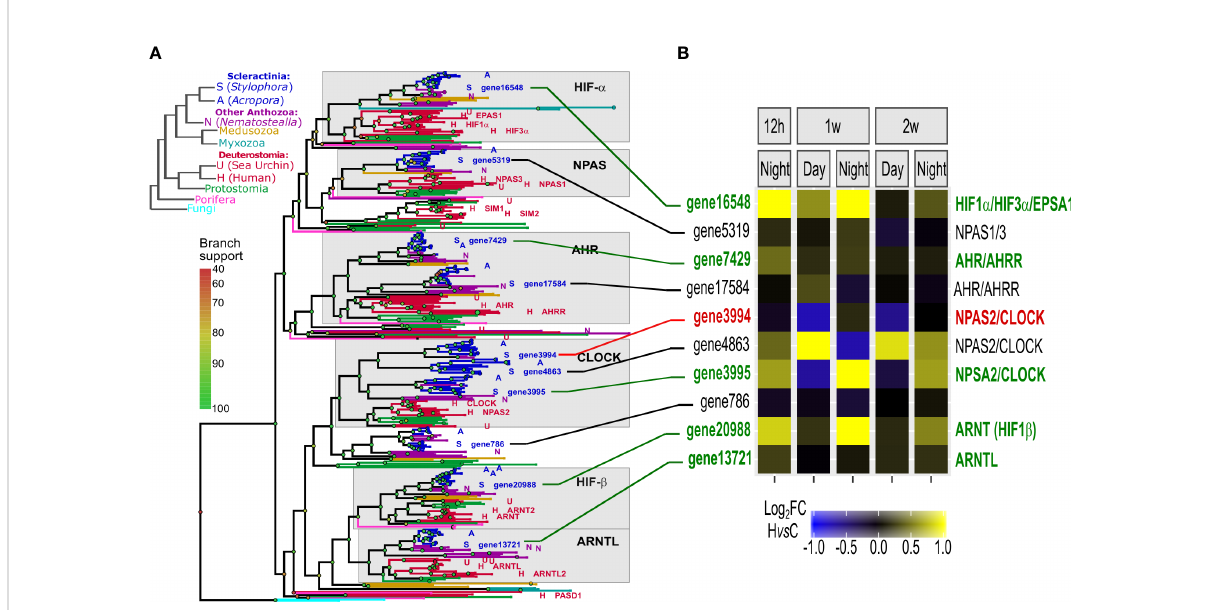
FIGURE 5 Functional and protein-structure conservation of HIFs in metazoa and cnidaria. (A) Left: Metazoan phylogenetic species-tree representing evolution of major species clades. Representative species are symbolled A/S/N/H to denote: Acropora , Stylophora , Nematostella , and human genes; Right: Gene tree representation of the HIF gene family in metazoa and fungi, with ~50 metazoa species represented. Leaf colors match the species-tree clade colors. Grey boxes represent six conserved groups of humans vs. cnidaria orthologs (Data S3). (B) A heatmap representation of S . pistillata gene H vs C log 2 fold changes, in each time point (values lower than -1 or higher than 1 are color-coded as maximum values) (Data S7). S. pistillata genes have the same order as in the gene tree, where Ids in red/green correspond to signi fi cantly down/ up-regulated genes, respectively. Ids in black correspond to not signi fi cant. Connecting lines are colored